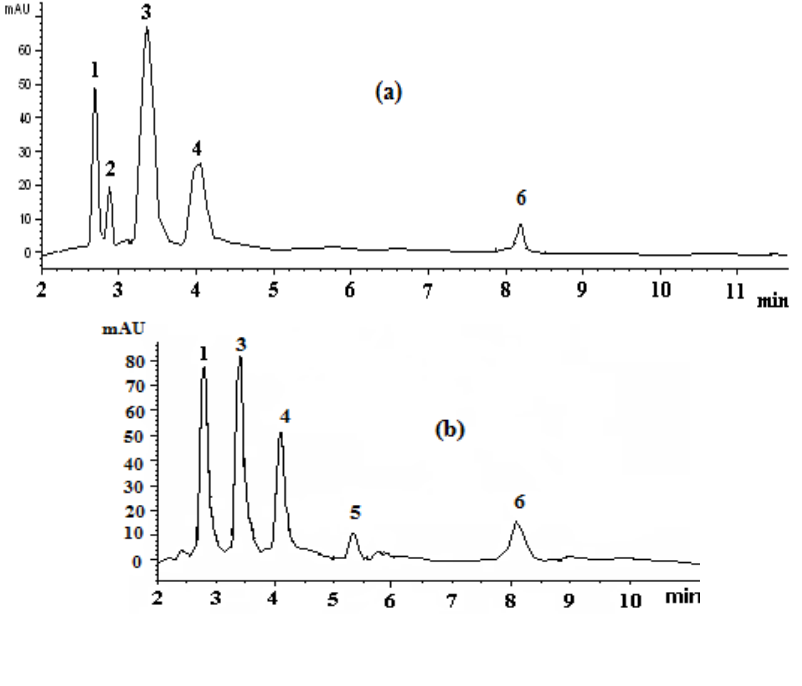
Figure 2. HPLC chromatograms of ( a ) duck and ( b ) goose egg yolk carotenoids. The identified peaks include: ( 1 ) all- trans zeaxanthin; ( 2 ) neolutein; ( 3 ) all- trans